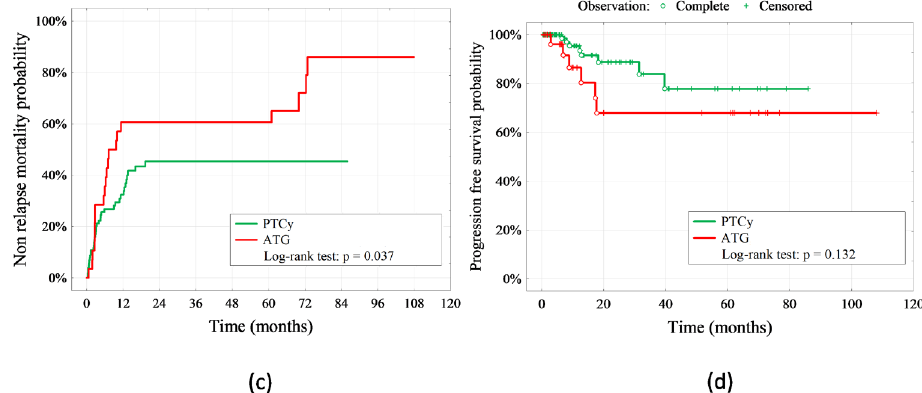
Figure 2. Kaplan–Meier curves for : ( a ) OS (overall survival), ( b ) aGvHD incidence, ( c ) NRM (nonrelapse mortality), ( d ) PFS (progression-free survival) .